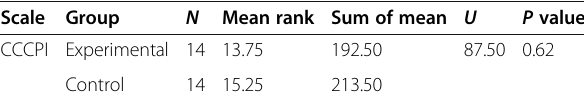
Table 6 Findings obtained from the pre- and post-test Wilcoxon signed-ranks test in the experimental group